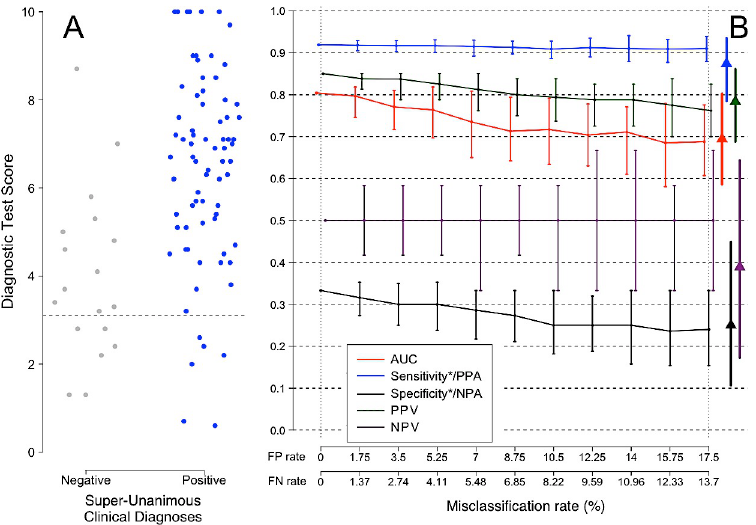
Fig 8. (A) Subset of pneumonia/LRTI-specific data (N = 93) from a clinical trial for a new sepsis diagnostic test, conducted over 8 sites in the USA and Netherlands [25]. (B) The apparent performance of the test (y axis) decreases as uncertainty is introduced into the comparator (x axis). 95% confidence intervals are shown. The difference between the apparent test performance at a given comparator misclassification rate and at a comparator misclassification rate of zero indicates the degree of underestimation of true test performance due to uncertainty in the comparator. Solid triangles show the observed measurements for the trial for each of these groups without correction for comparator uncertainty. Misclassification rates are based on quantifying the discordance between independent expert opinions. Sensitivity/PPA and Specificity/NPA are each marked with an asterisk ( � ) to emphasize that these measures assume no misclassification in the comparator. Positive Percent Agreement (PPA) and Negative Percent Agreement (NPA) are the correct terms to use, when the comparator is known to contain uncertainty as in this